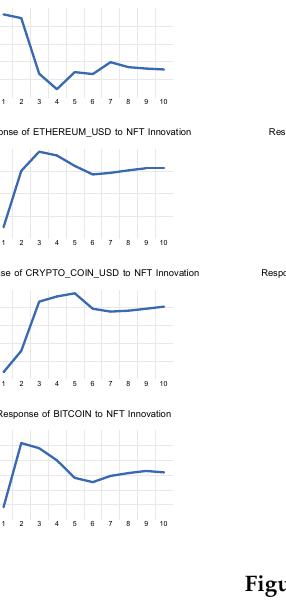
Figure 3. Impulse Response Functions.